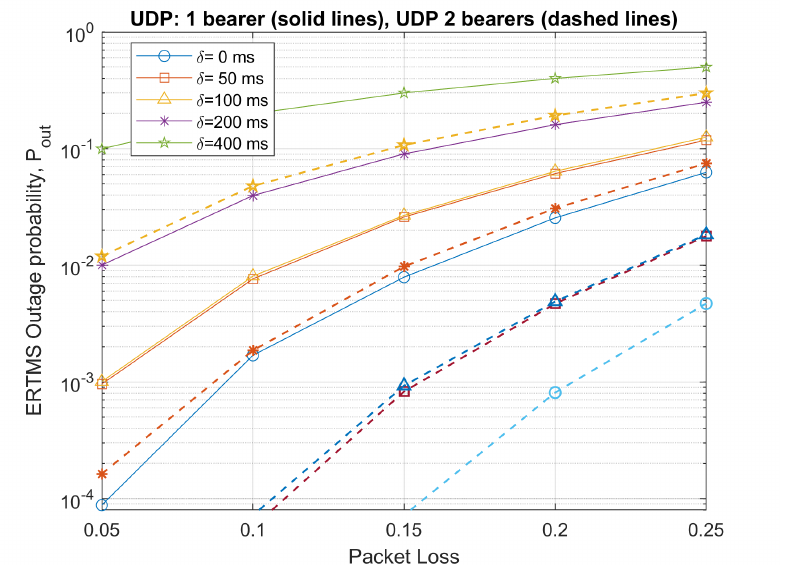
Figure 14. PR/MA over-limit percentage vs. network packet losses for one UDP bearer and two UDP bearers: considered delays are 0, 50, 100, 200 and 400